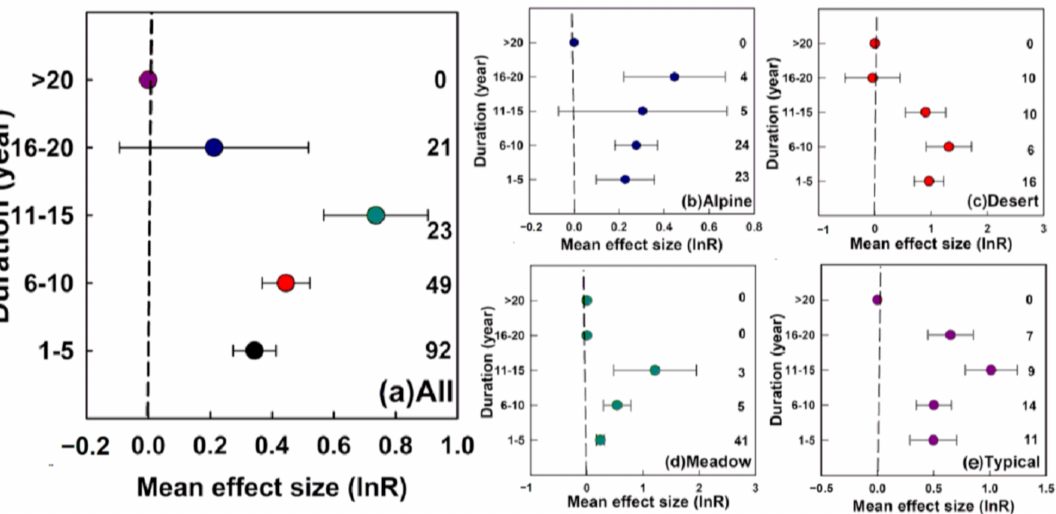
Figure 3. The effect value of vegetation coverage throughout different enclosure years ( a ), as well as the reaction of different types of grassland vegetation coverage to enclosure ( b – e ). The values are calculated effect sizes and 95% confidence intervals. Sample sizes are given to the right of the